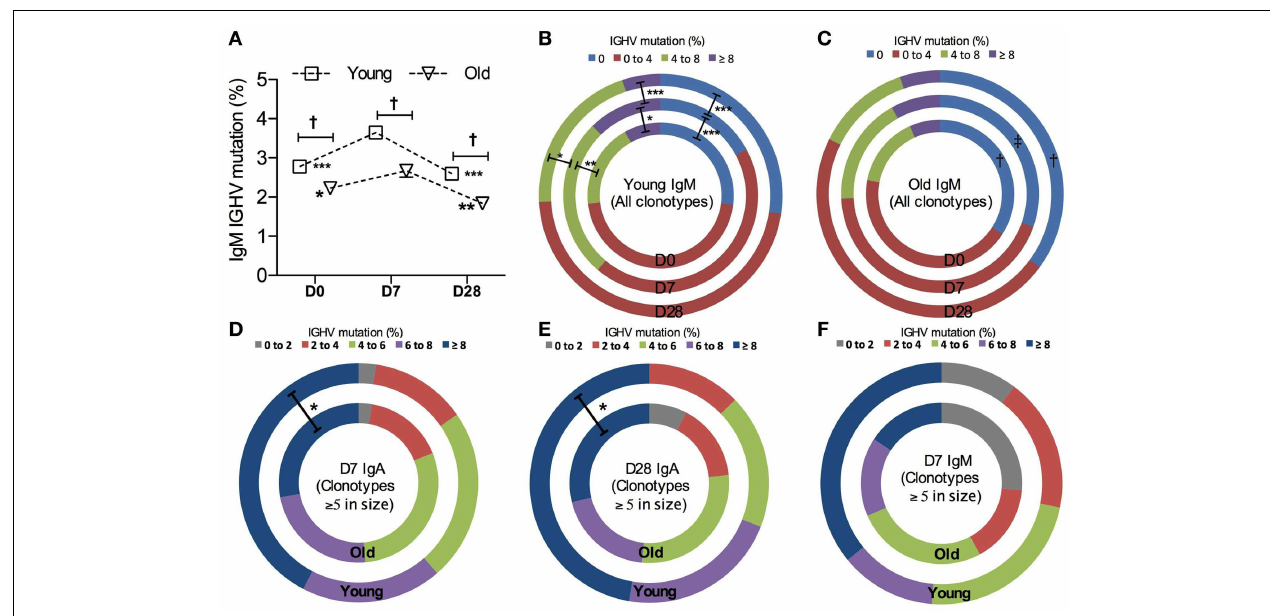
proportion of each group was compared using Chi-squared tests between days (D0: inner circles, D7: middle circles, and D28: outer circles; * p < 0.05, ** p < 0.005, and *** p < 0.0005) and between six young (B) and six old (C) donors [ † p < 0.05 and ‡ p < 0.005, as indicated in (C) ]. For clones ≥ 5 in size, IgM clonotypes at D7 (D) , IgA clonotypes at D7 (E) , and IgA clonotypes at D28 (F) were grouped by the level of IGHV mutations and the proportion of each group was compared between six young (outer circles) and six old (inner circles) donors, using Chi-squared tests (* p <